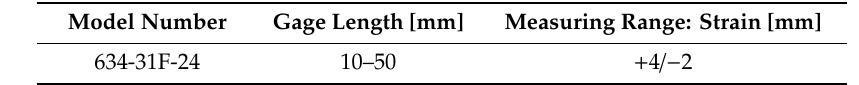
Figure 6. Test of uniaxial compression for specimens, testing machine Isntron 1342 and MTS634-31F- 24 extensometer.